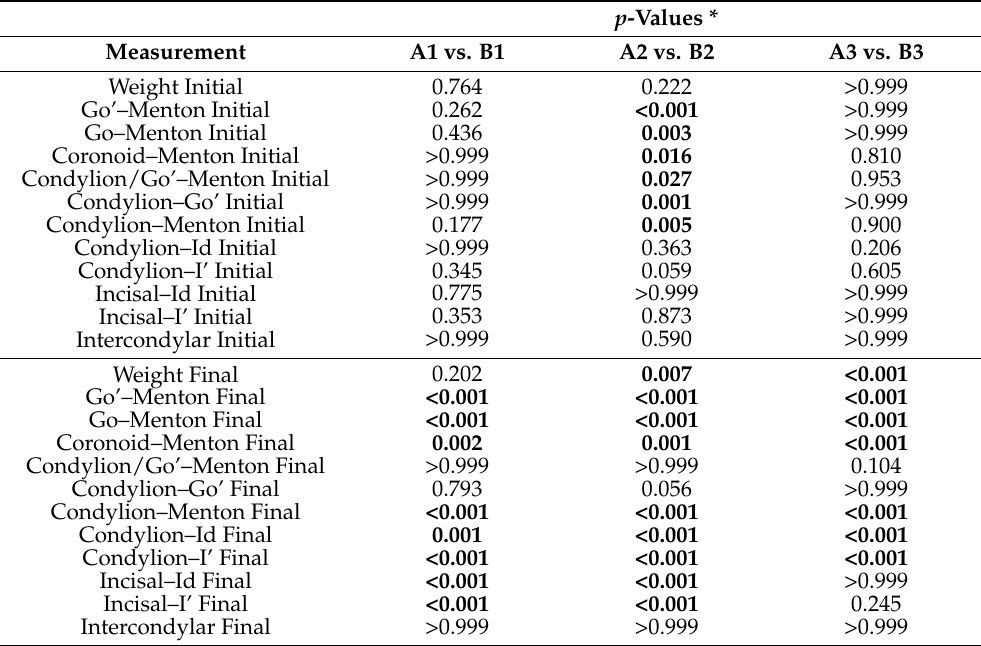
Table 4. Pairwise group per timing measurements comparisons’ p -values derived from linear regres- sion models, adjusted for multiple comparison (Bonferroni).